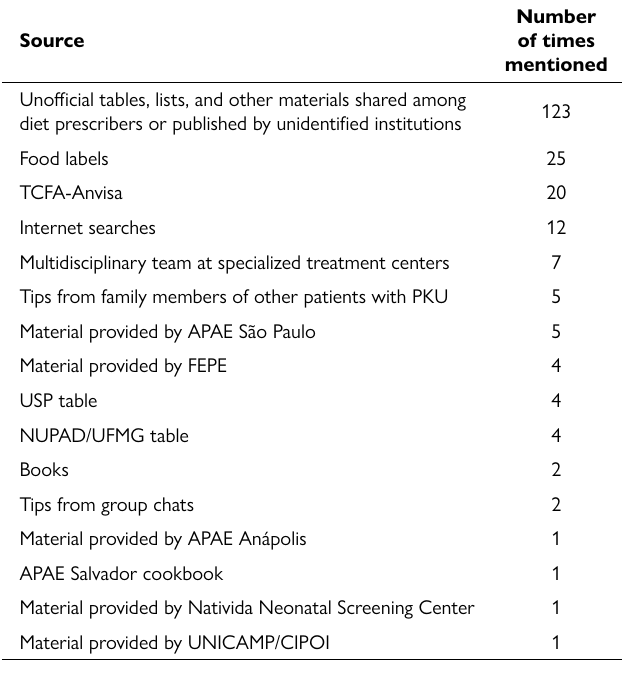
Table 2. Sources of information on Phe content of foods mentioned by patients, family members, and caregivers.